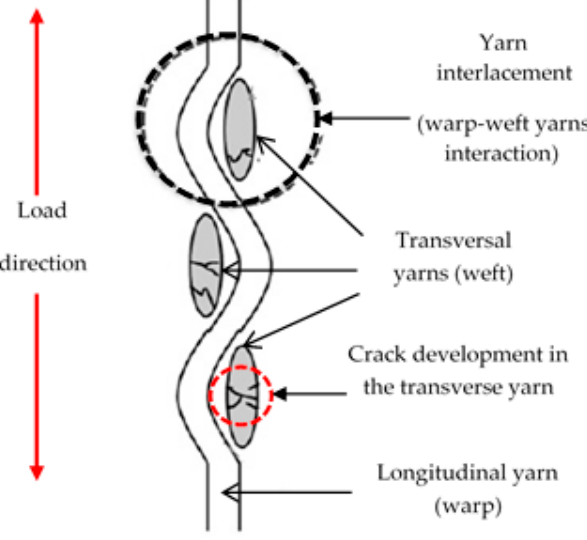
Figure 4. Development of failure perpendicular to the loading direction i.e., in transverse direction [35].